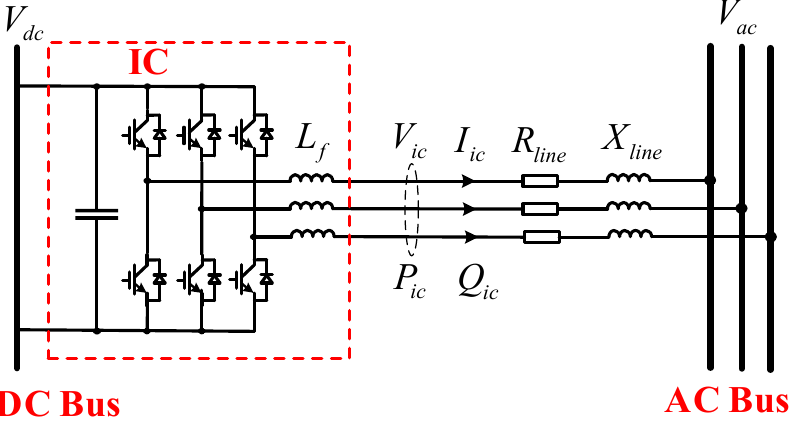
Figure 2. Schematic diagram of IC.